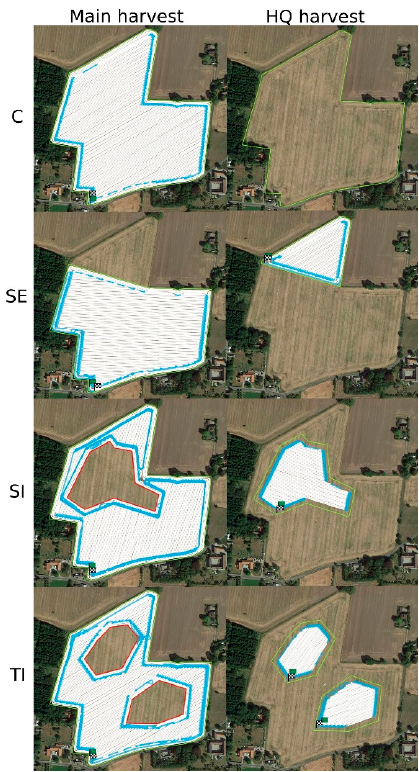
Figure 4. Route plans for field L1 for the four harvest cases, i.e., conventional (C), single edged case (SE), single in-field case (SI) and twofold in-field case (TI). White lines represent working paths and blue lines the connection paths. Table 2. Detailed estimated harvest times in seconds of field L1 for the four harvesting cases and their field divisions.